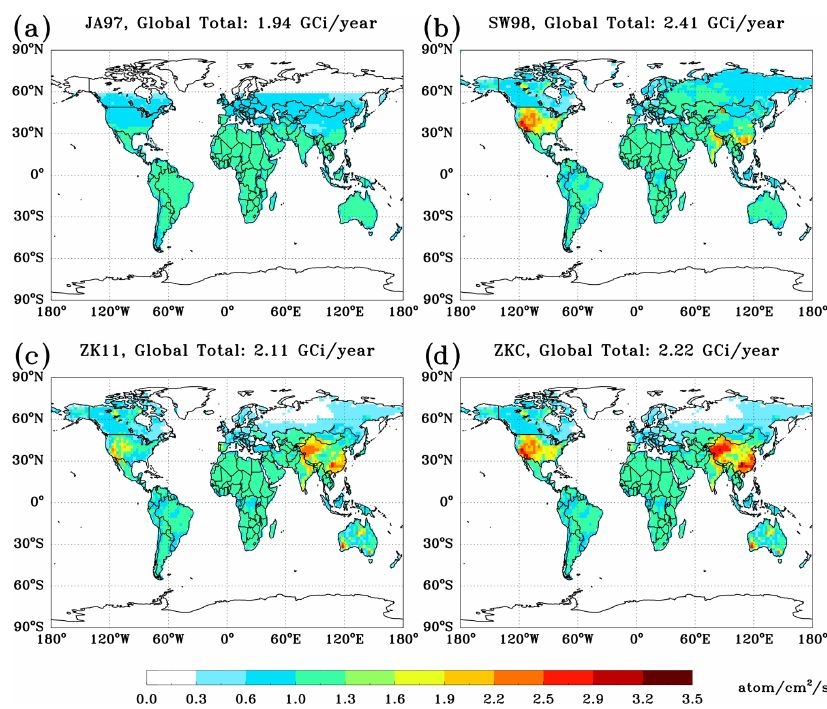
Figure 1. Global annual mean surface 222 Rn emission fluxes (atomcm − 2 s − 1 ) of four emission scenarios used in this study. (a) JA97, the default emission scenario in the standard version of GEOS-Chem (Jacob et al., 1997); (b) SW98, the first global 222 Rn emission inventory with regional variability based on a soil emission model (Schery and Wasiolek, 1998); (c) ZK11, a recently published global 222 Rn emission inventory combining SW98 and recent measurements of 222 Rn fluxes (Zhang et al., 2011); and (d) ZKC, which is ZK11 with customized adjustments to better match observations (this